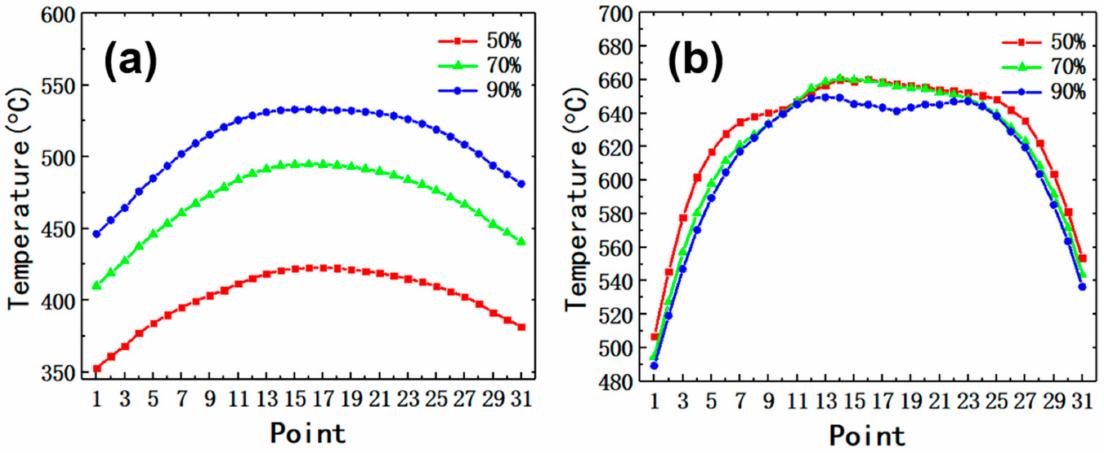
Figure 17. Distribution of temperature of interface between aluminum and steel under different degrees of deformation: ( a ) aluminum, ( b )